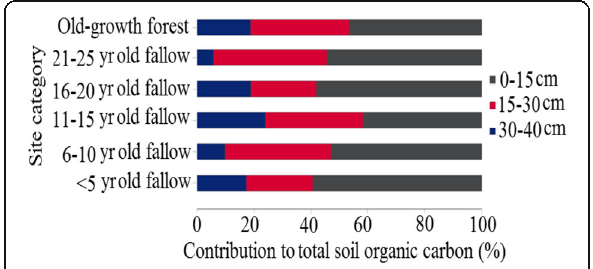
Fig. 4 Distribution of soil organic carbon stocks (SOC) along the soil depths in the study sites. The values are percentage contribution to their corresponding total SOC stock (0 – 45 cm soil